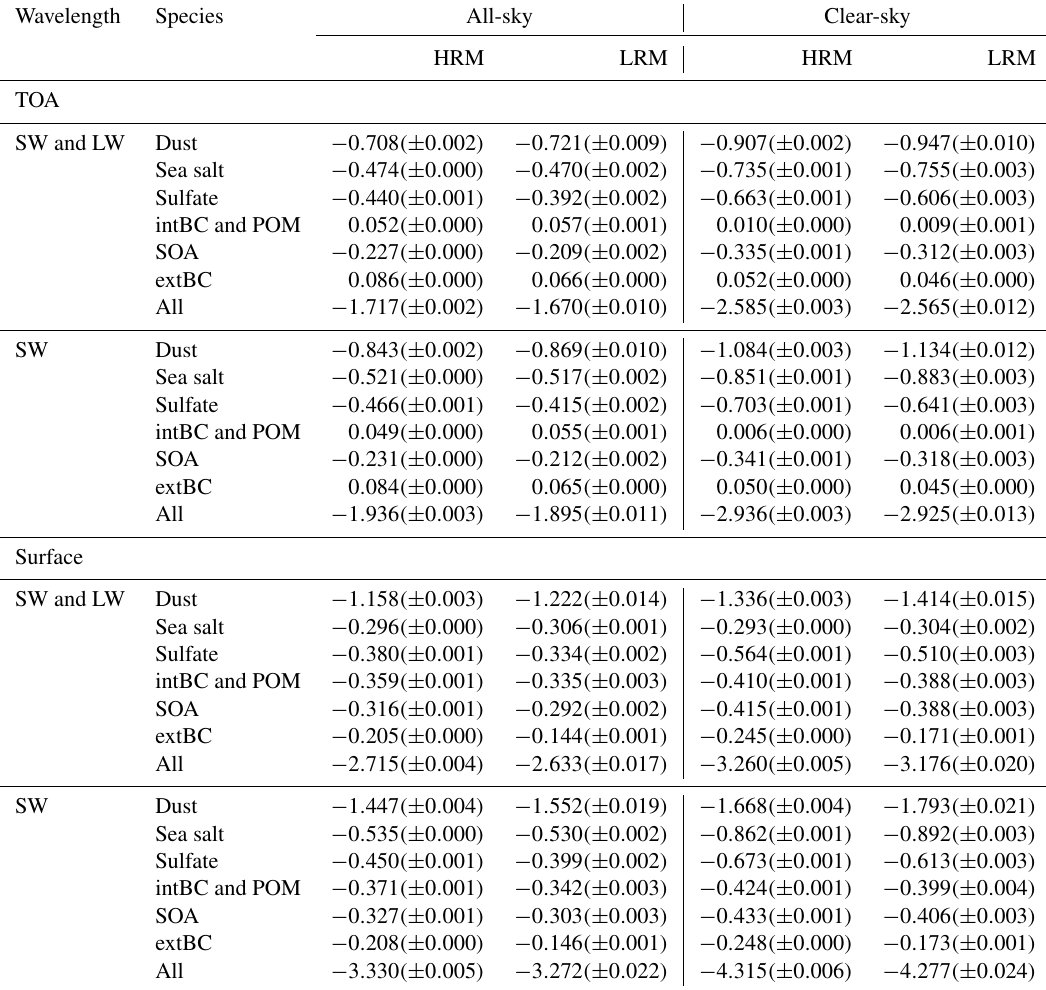
Table 3. IRFari 1 at the top of atmosphere (TOA) and the surface with the uncertainties 2 in units of Wm − 2 . Wavelength Species